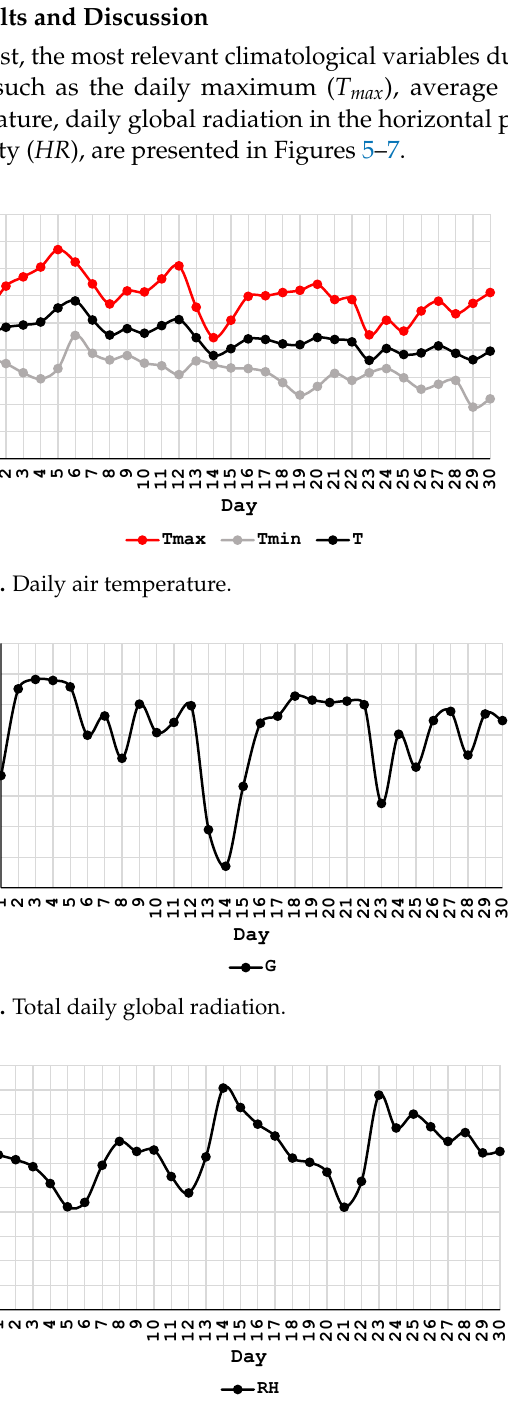
Figure 7. Average daily Relative Humidity.